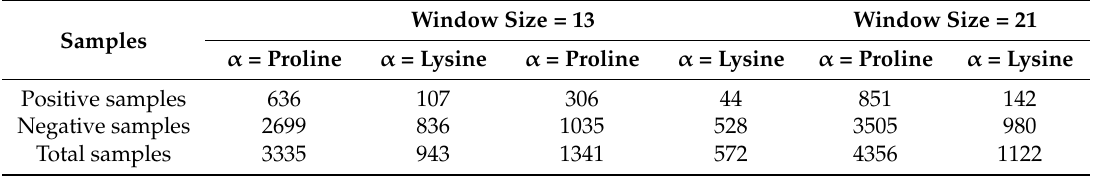
Table 7. Positive and negative peptide samples of proline and lysine site.